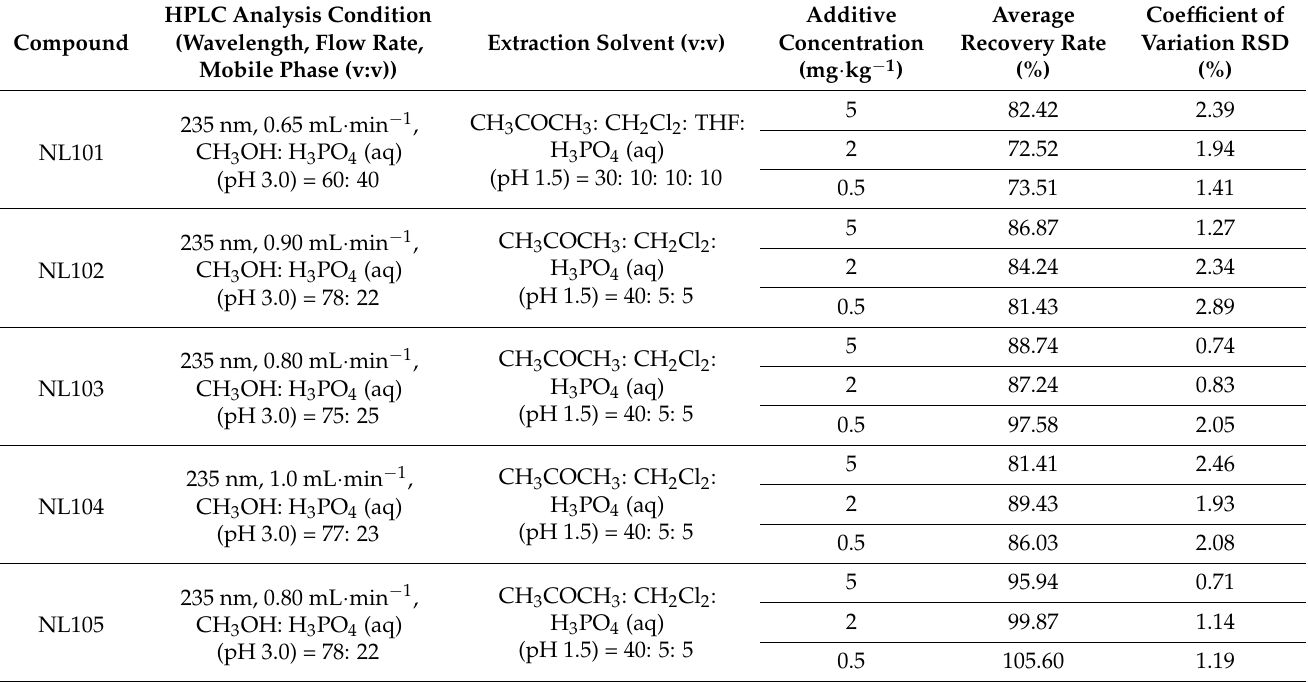
Table 2. Analytical data on the recovery rates of three concentrations (in soil with pH